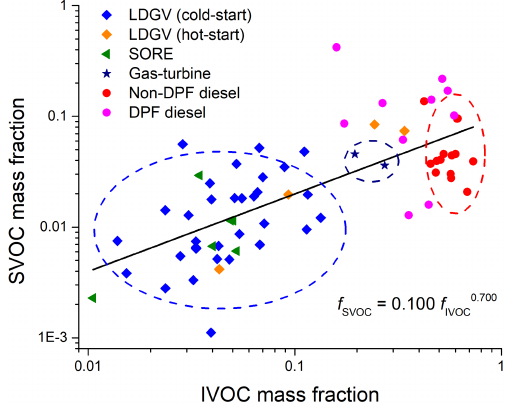
Figure 4. Two-dimensional visualization of volatility distributions ( x axis: IVOC mass fraction, y axis: SVOC mass fraction) of all tested sources. Dashed circles indicate clusters by fuel type. Blue cluster: gasoline (cold-start), navy: gas-turbine, red: non-DPF diesel